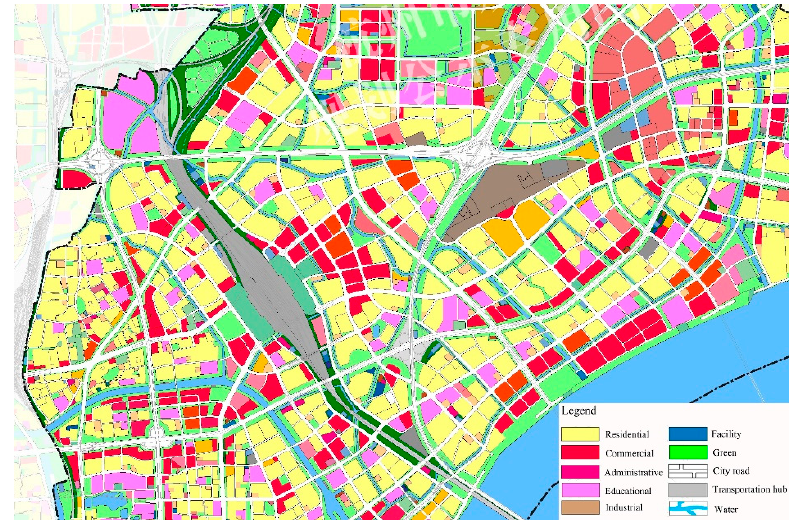
ffi ce urban planning map for Hangzhou Figure 10. Office urban planning map for Hangzhou (partial). Figure 10. O